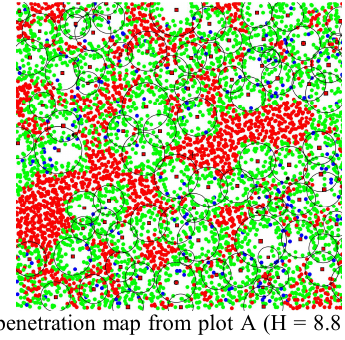
Fig. 3. Pulse penetration map from plot A (H = 8.8 m). The circles depict the crown area at the crown base. Red dots are pulses with a single return; green denotes two-return pulses and blue is for three- and four-return pulses.